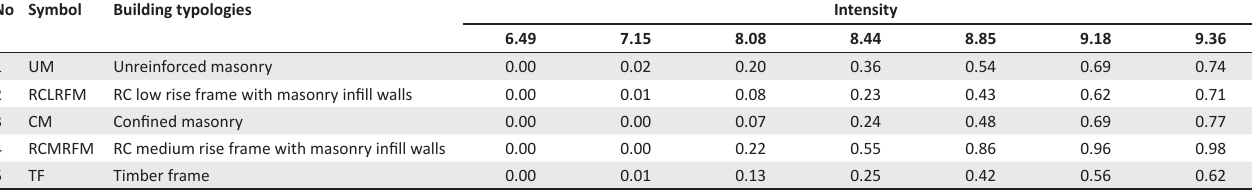
TABLE 3: Damage index derived from vulnerability curve from the Padang earthquake damage observations. No Symbol Building typologies